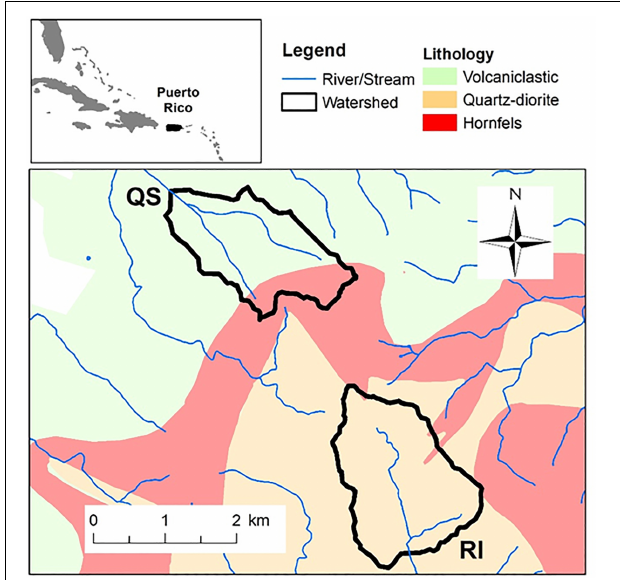
FIGURE 1 | Map of the Luquillo Mountains, Puerto Rico, and the drainages of Quebrada Sonadora (QS) and Rio Icacos (RI) outlined in bold. Colors represents differences in